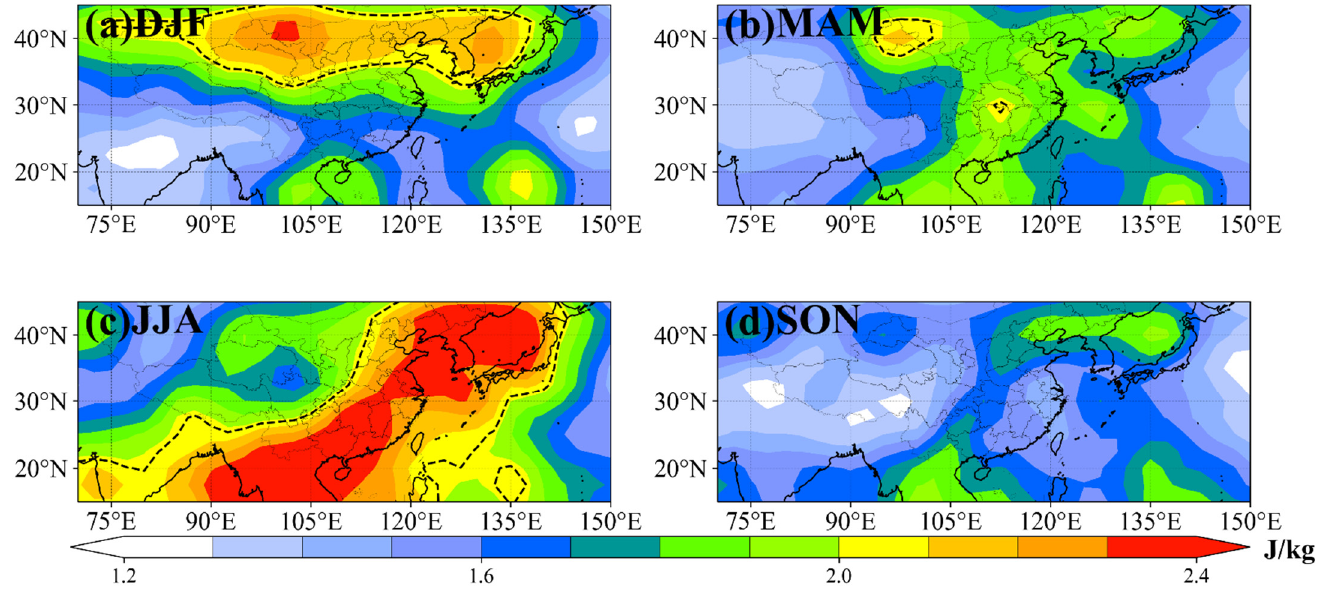
Figure 4. Same as Figure 3, but for the middle stratosphere. ( a ) DJF, ( b ) MAM, ( c ) JJA, and ( d ) SON.